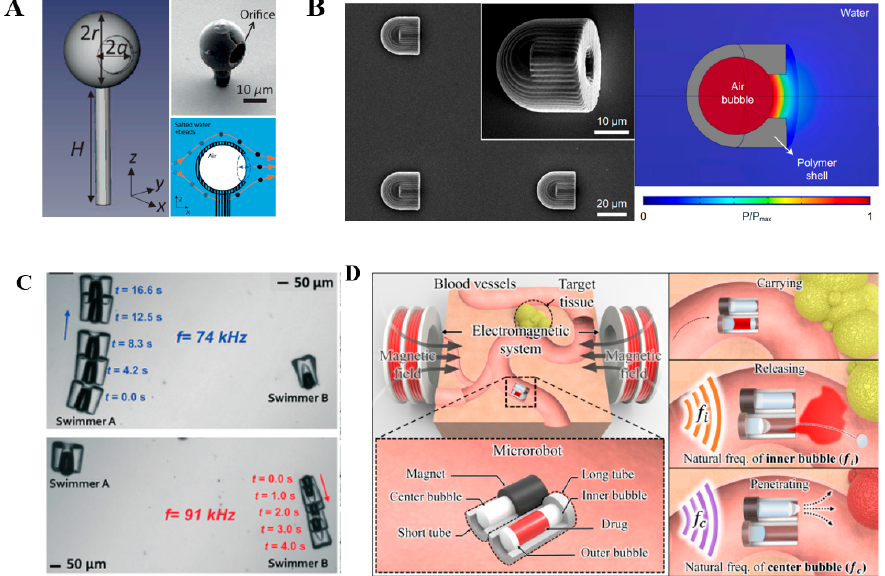
Figure 5. Different designs of bubble propulsion. ( A ) Long-lasting armored microbubble under forced vibration. ( B ) Scanning electron microscopy images of the microrobot. The simulated acoustic pressure map at the resonance frequency. ( C ) The low-power acoustic field actuation oscillatory motion of a bubble enables directional motion in water. Two microswimmers with bubbles of different sizes enable independent control of each body. ( D ) Schematic diagram of proposed drug delivery technology. Reproduced with permission from Refs. [8,59–61], respectively.